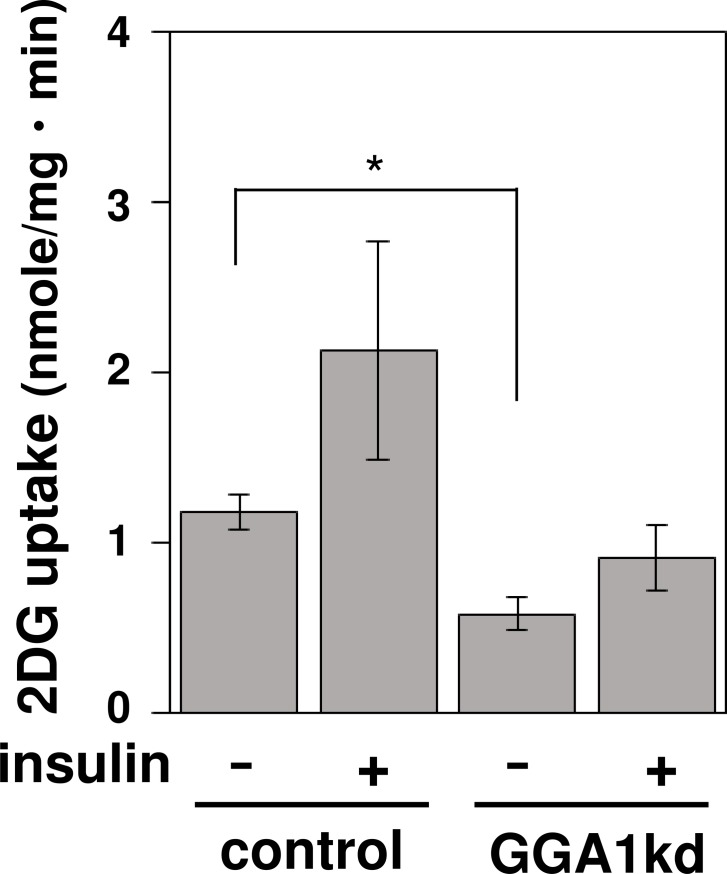
Gga1 silencing affects the insulin-dependent glucose uptake of myotubes.Control and Golgi associated, gamma adaptin ear containing, ARF binding protein 1 gene knockdown (Gga1kd) myotubes were prepared as in Fig 4, and the uptake of 2-deoxy-D-glucose (2-DG) in the absence or presence of 1 mM insulin was assayed as described in the Materials and methods. Error bars indicate the SD (n = 3). *. P < 0.05 by a Student’s t-test.